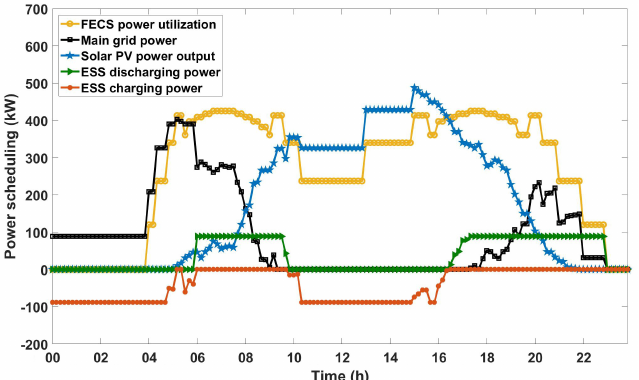
Figure 3. Daily power scheduling for an integrated FECS with commute demand, solar PV (533 kW), and ESS (592 kWh).